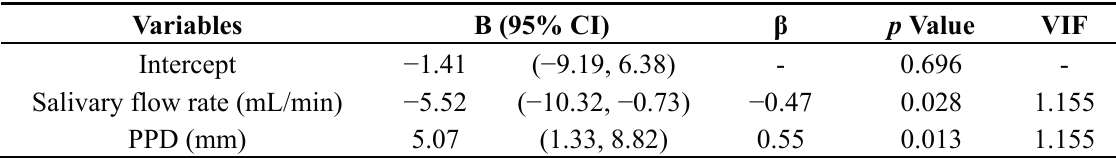
Table 4. Multiple linear regression analysis with the relative expression rates of miR-24-3p as the dependent variable in old group (N =